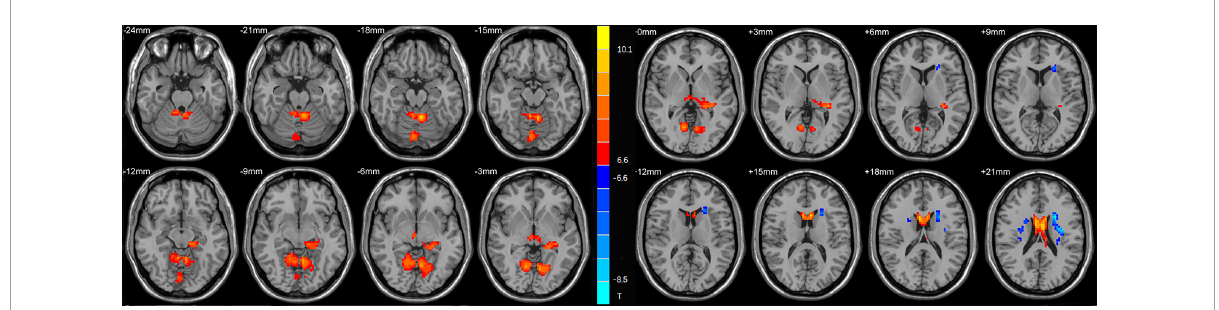
FIGURE1 Statistical map depicts higher and lower degree centrality (DC) of major depressive disorder (MDD) patients compared with healthy controls (HCs). The threshold was set at p < 0.01. Blue denotes lower DC, and red denotes higher DC. The color bar indicates t -values from the two-sample t